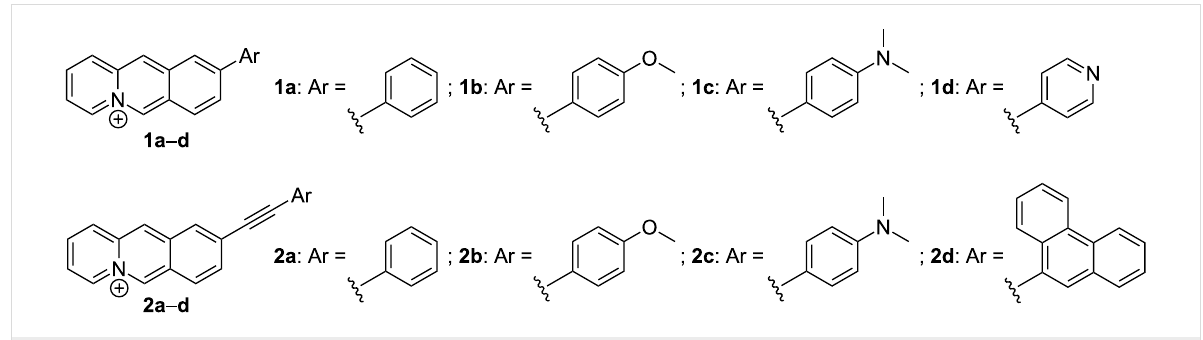
Figure 1: Structures of 9-substituted benzo[ b ]quinolizinium derivatives 1 and 2